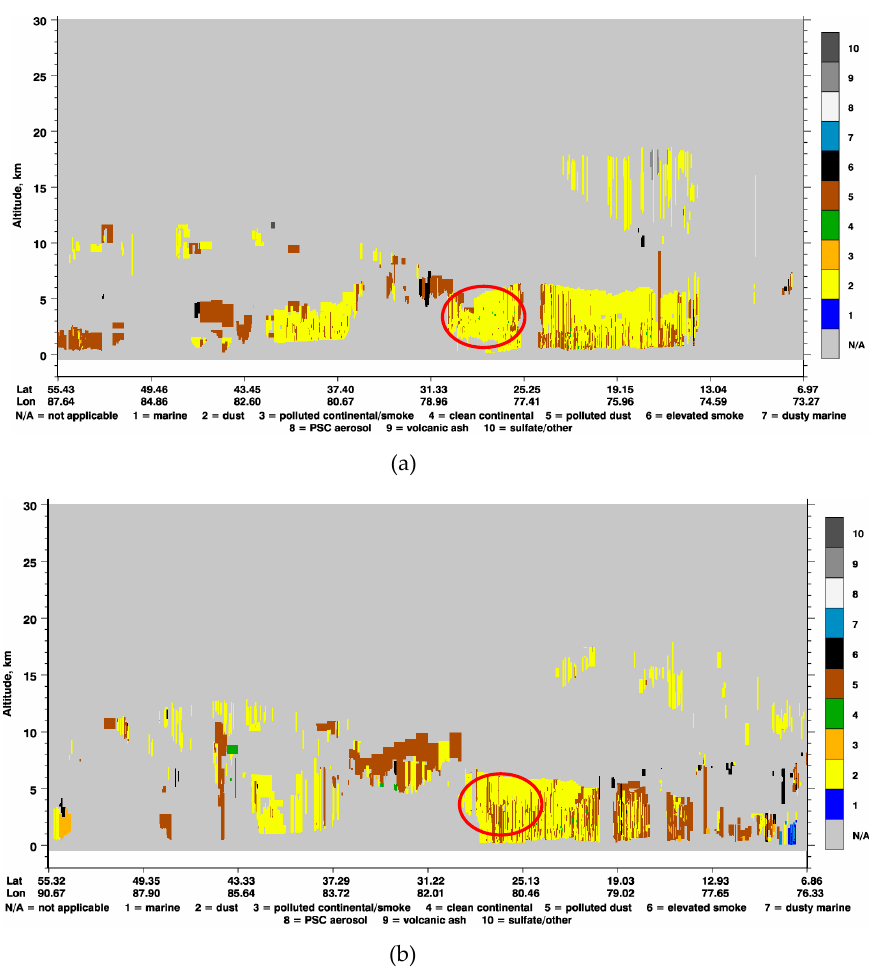
Figure 8. ( a ) Vertical stretch of dust at 20:42:26.8 to 20:55:55.4 UTC on 13 June 2018 captured by CALIPSO [32]. The red circled area shows vertical reach of dust; ( b ) Vertical stretch of dust at 20:30:08.0 to 20:43:36.7 UTC on 15 June 2018 captured by CALIPSO. The red circled area shows vertical reach of dust.